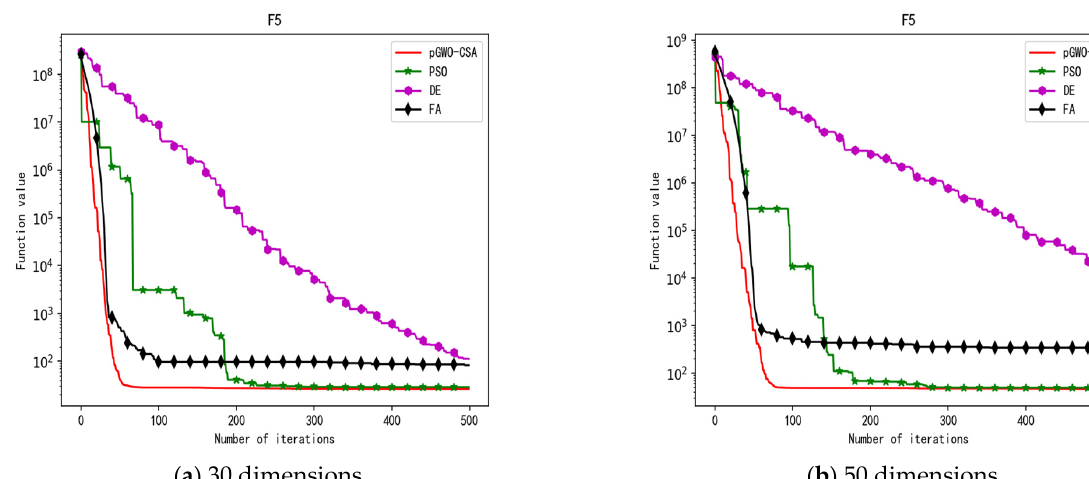
Figure 8. Convergence curve of test function F4.